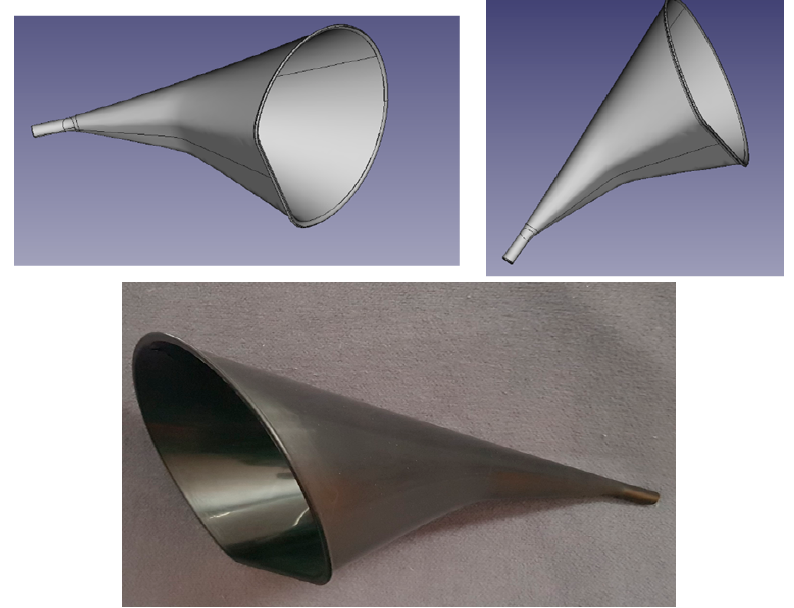
Figure 1. Dental Aerosol Suction Device